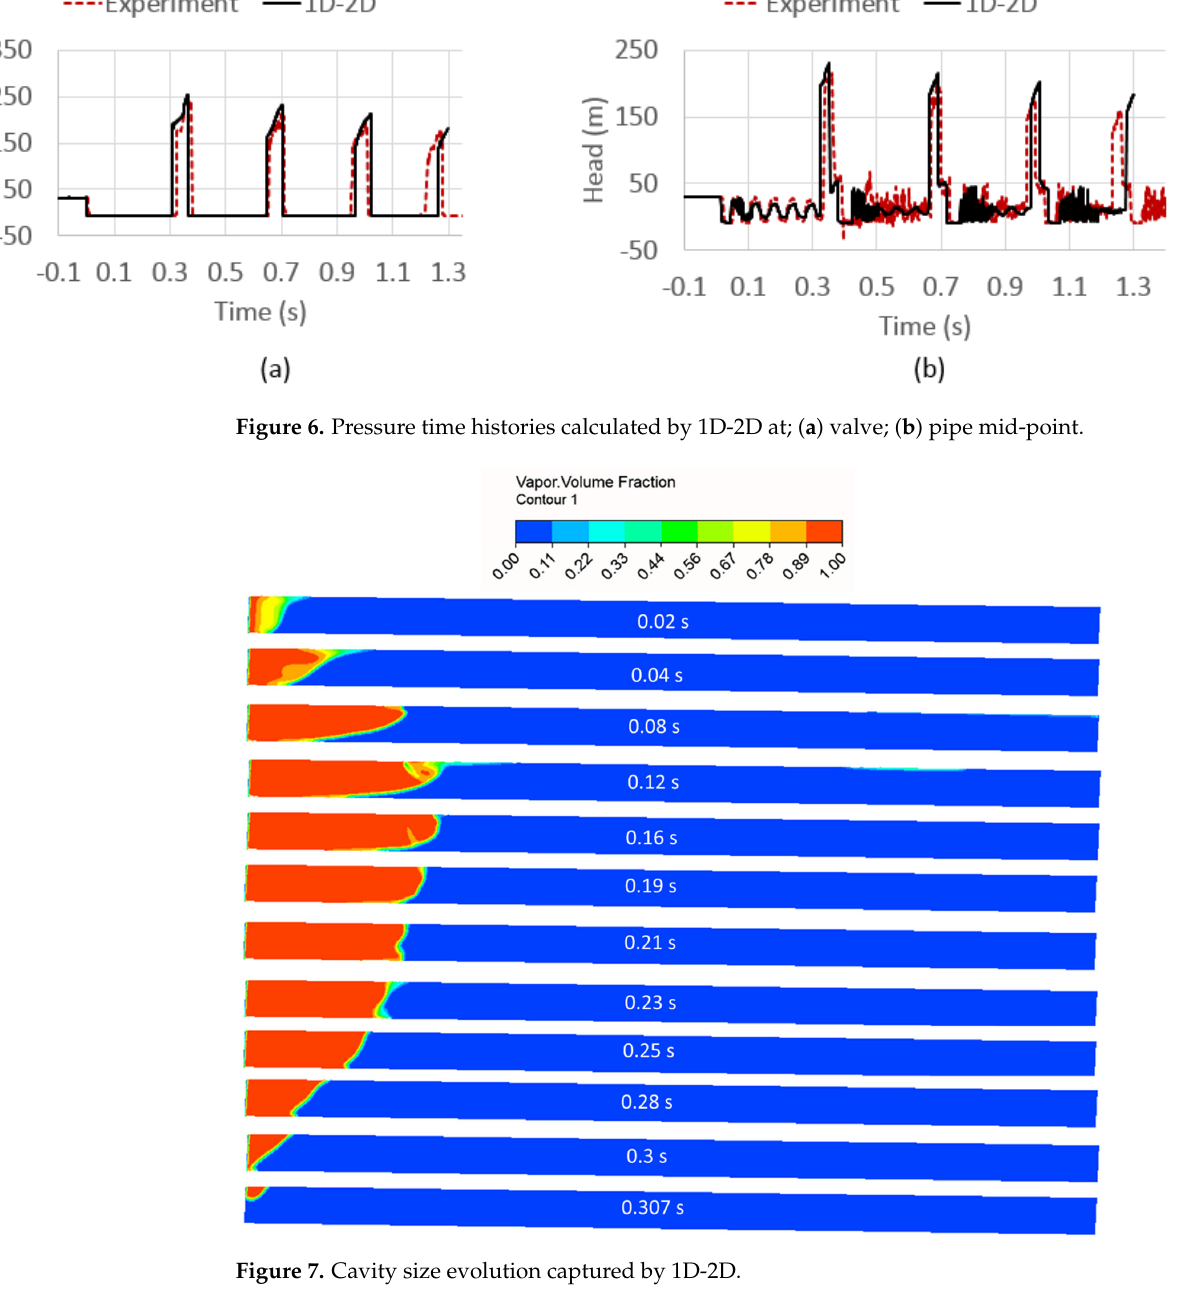
Figure 8. Pressure time histories calculated by 1D-3D at; ( a ) valve; ( b ) pipe mid-point.